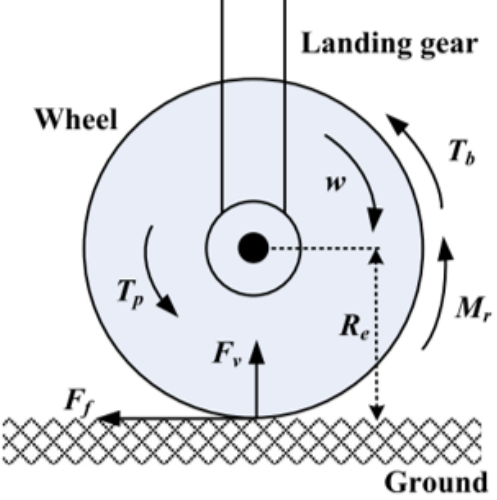
Figure 7. Force analysis of the main wheel during the braking